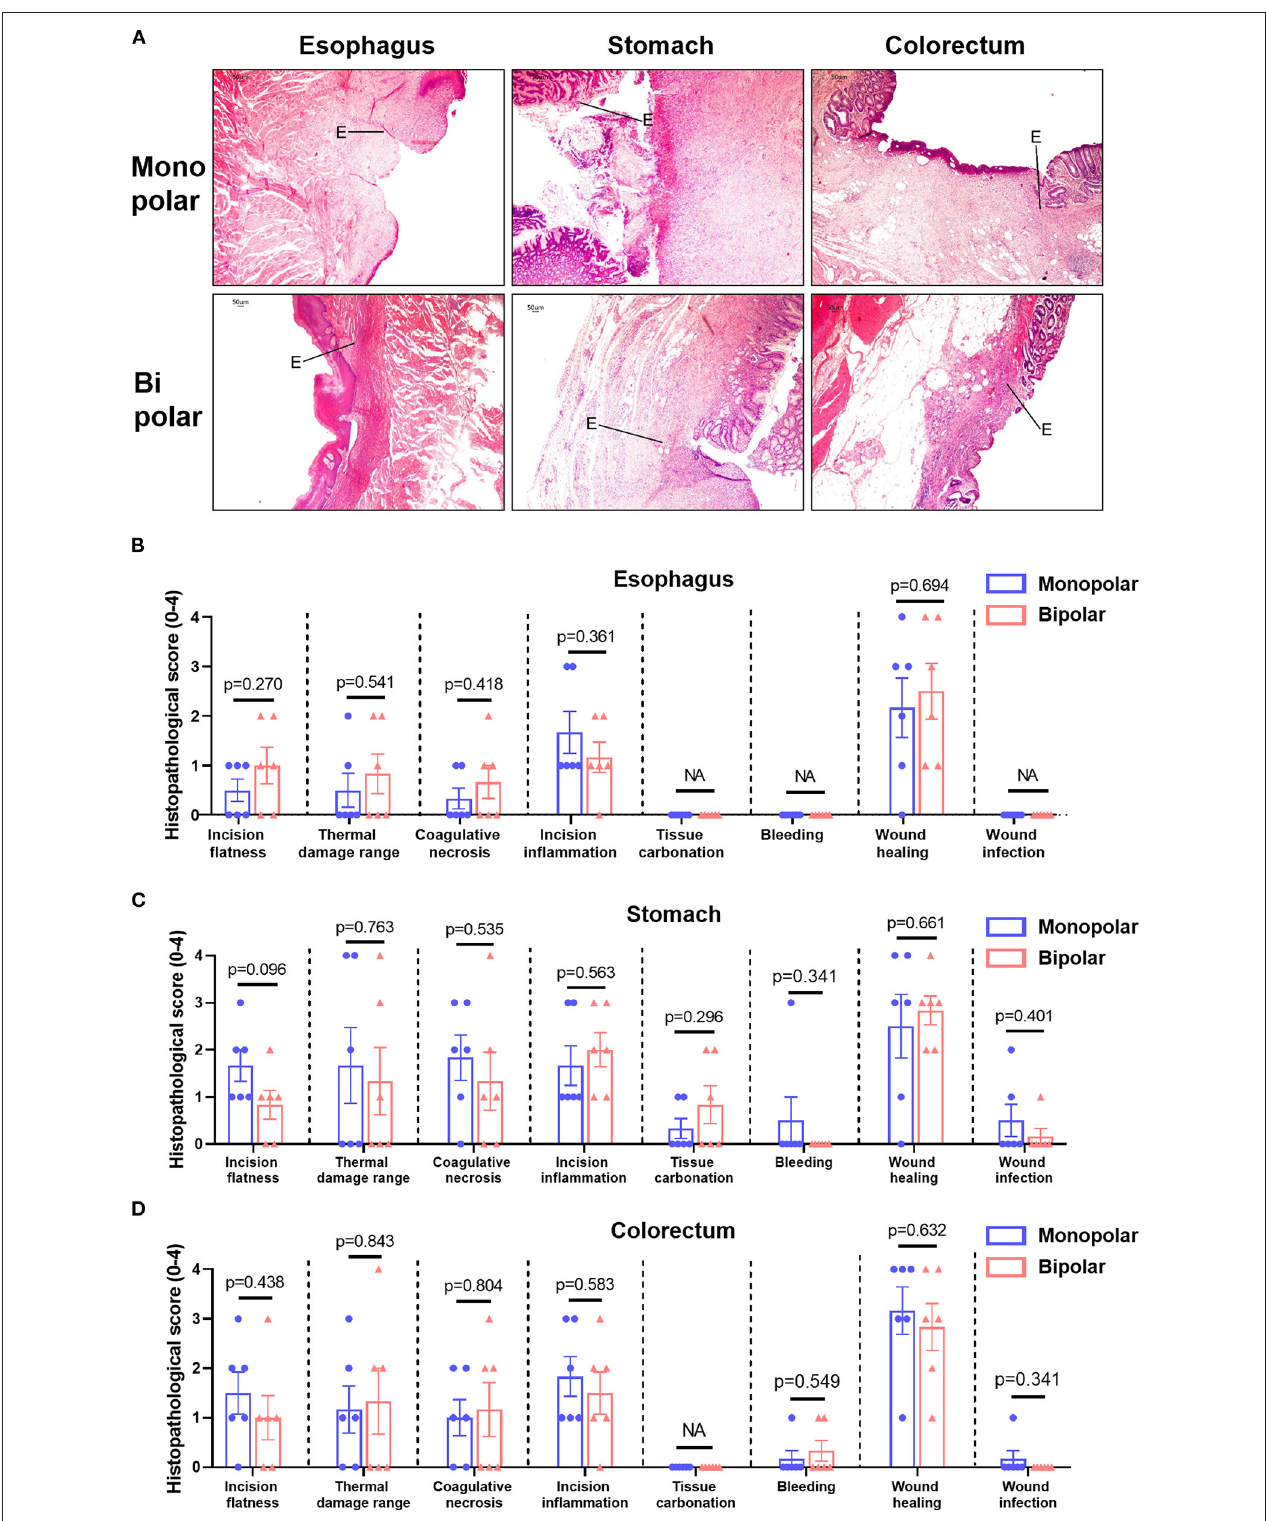
FIGURE 5 | Histological changes of the digestive tract caused by the monopolar and bipolar knives in the chronic group. (A) Results of H&E staining about porcine esophageal, gastric and colorectal tissues resected by the two knives. Scale bar: 50 µ m. The edges of wounds were indicated by solid line. Comparison of histological scores on incision flatness, thermal damage range, coagulative necrosis, incision inflammation, tissue carbonation, bleeding, wound healing, and wound infection between monopolar and bipolar groups in esophagus (B) , stomach (C) , and colorectum (D) . The evaluation standards of these histological scores are summarized in Supplementary Table 3